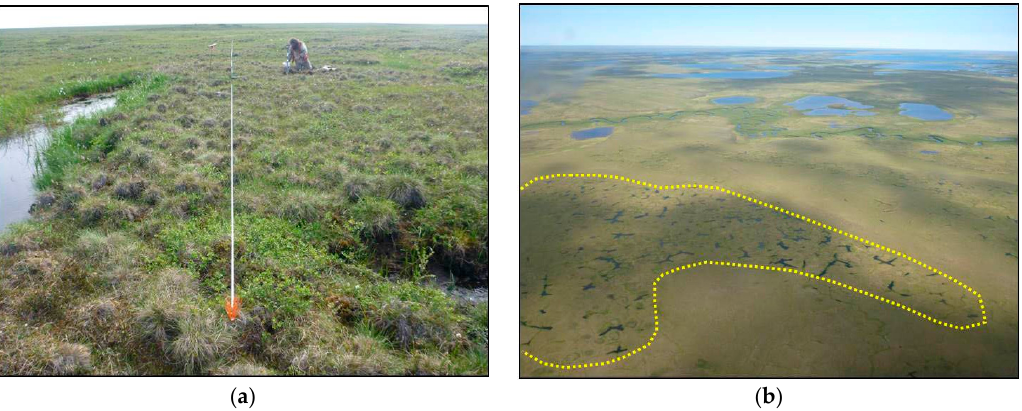
Figure 1. Ground ( a ) and aerial ( b ) views of recently formed thaw pits among high-centered polygons at Oumalik River study area, North Slope, Alaska.